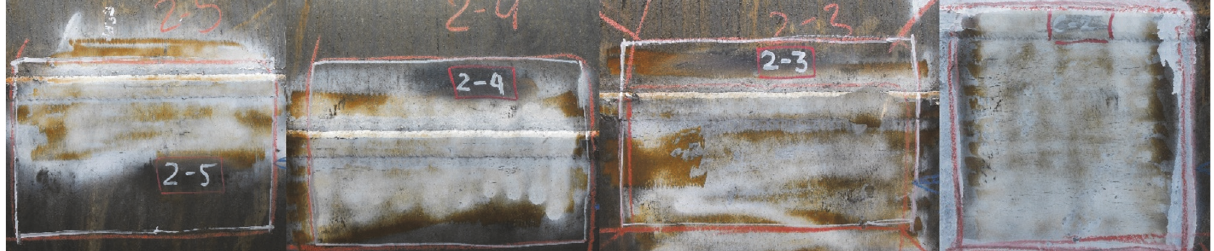
Figure 2: Samples with SCC cracks.